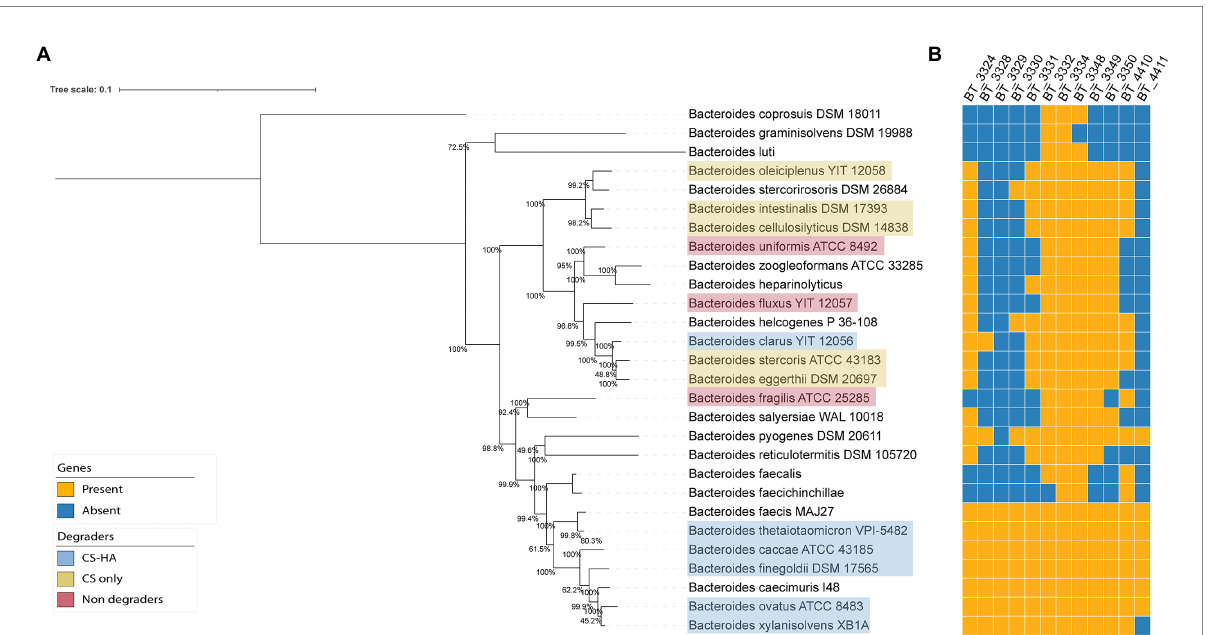
FIGURE 3 (A.B) Phylogenomic tree of gut Bacteroides and gene repertoire of putative CS and HA utilization genes. Phylogenetic tree of all Bacteroides species from NCBI with a translated CDS file. Genomes were aligned with CheckM (Parks et al., 2015) and the tree was calculated using iqtree2 (Minh et al., 2020). Clustering is not based on degradation capabilities of CS and/or HA. BlastP (cut-off evalue = 1e − 40 ) was used to create a presence/absence table of genes from B. theta (potentially) required for chondroitin sulfate (CS) and hyaluronan (HA) degradation based on literature and transcriptomic results. BT_3328 seems to be the crucial gene for HA degradation as bacteria without this gene are incapable of growth on